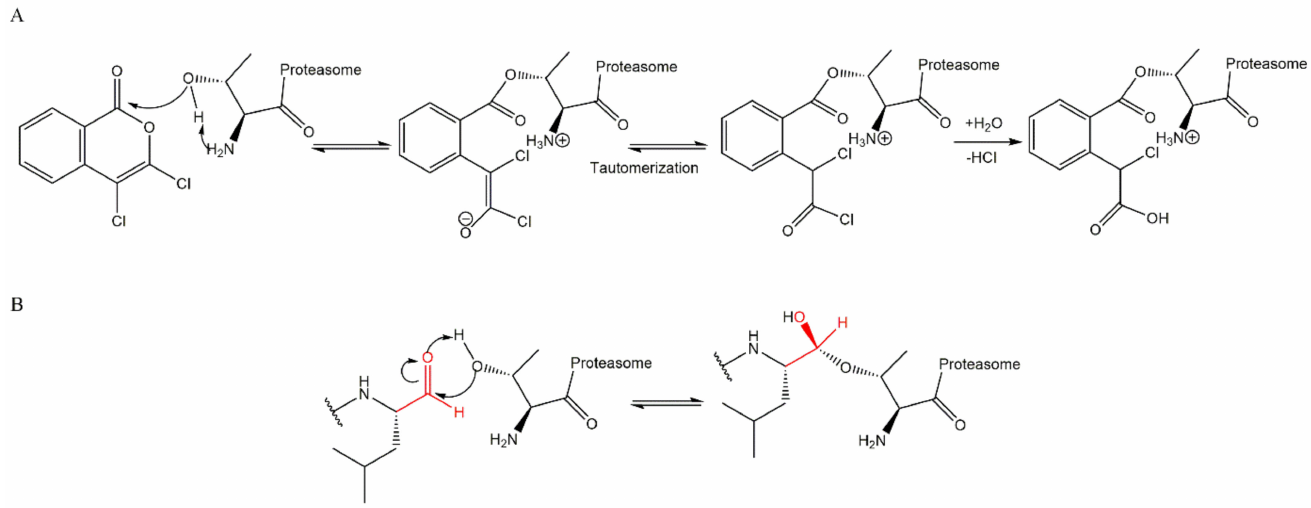
Figure 6. Mechanism of 20S CP inhibition by 3,4-dichloroisocoumarin ( A ) and by a peptide aldehyde ( B ). The hydroxyl group from Thr1 reacts with the carbonyl group of the inhibitor with the formation of a hemiketal, which is similar to a transition state of enzymatic reaction [27,29,30]. The peptide aldehyde inhibitors CEP1612, MG115, MG132 and PSI (Figure 7) are inhibitors of serine and cysteine proteases; however, they also inhibit the 20S CP and have increased selectivity to it when compared to the previously described inhibitors [27]. This experimental